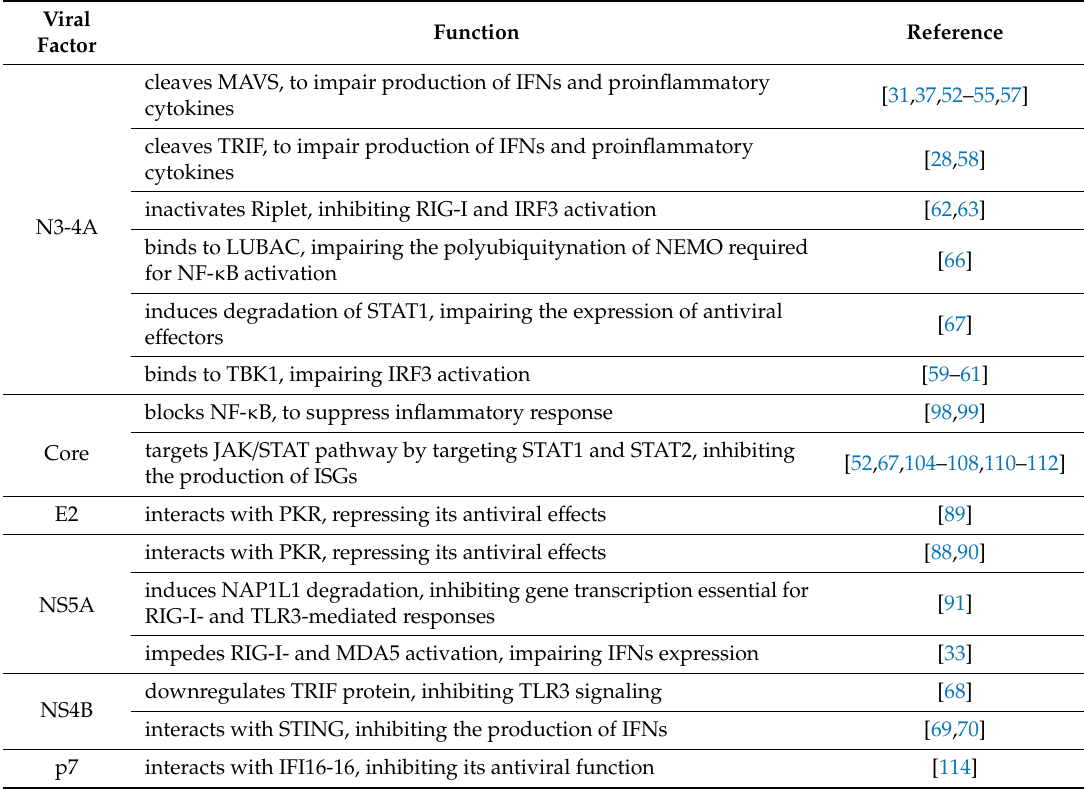
Table 1. Roles of hepatitis C virus (HCV) proteins on the evasion of the intracellular antiviral response.